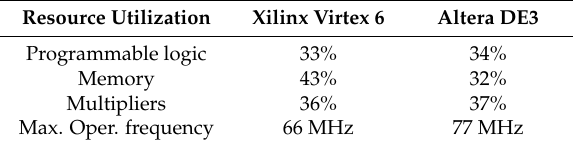
Table 2. Resource utilization in fiel programmable gate array (FPGA) from two different vendors.